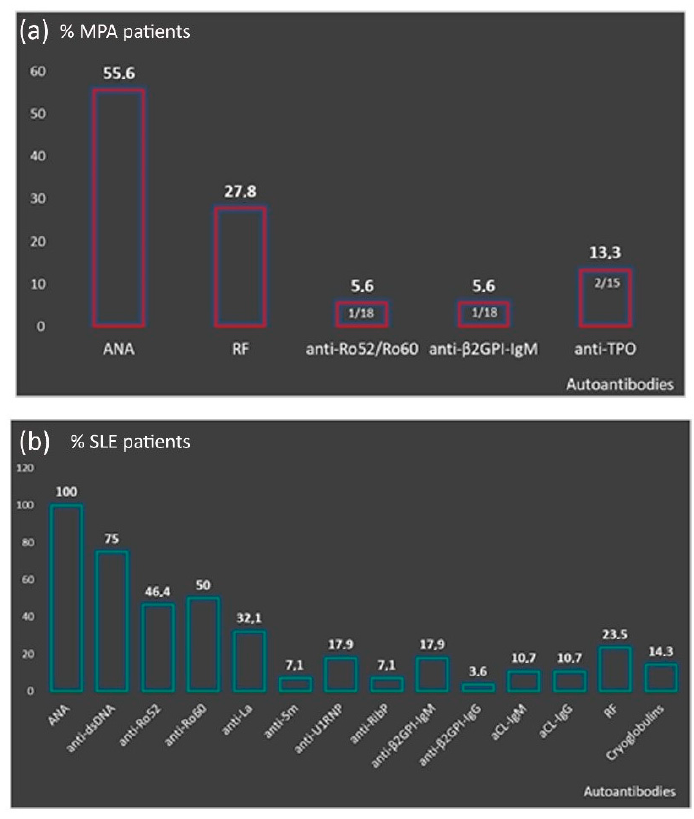
Figure 2. Autoantibody profile of P-ANCA positive patients. ( a ) Presence other than P-ANCA autoantibodies in MPA patients; ( b ) distribution of autoantibodies in the context of SLE. P-ANCA: perinuclear antineutrophil cytoplasmic antibodies, MPA: microscopic polyangiitis, SLE: systemic lupus erythematosus, ANA: antinuclear antibodies, RF: rheumatoid factor, aCL: